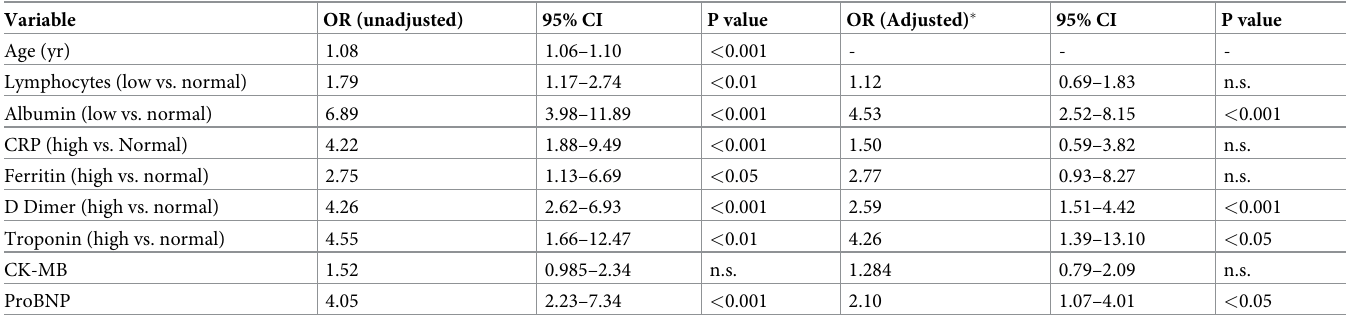
Table 5. Multivariate logistic regression analysis of inflammatory and cardiac markers results upon hospital admission associated with AKI development. Variable OR (unadjusted) 95% CI Lymphocytes (low vs.